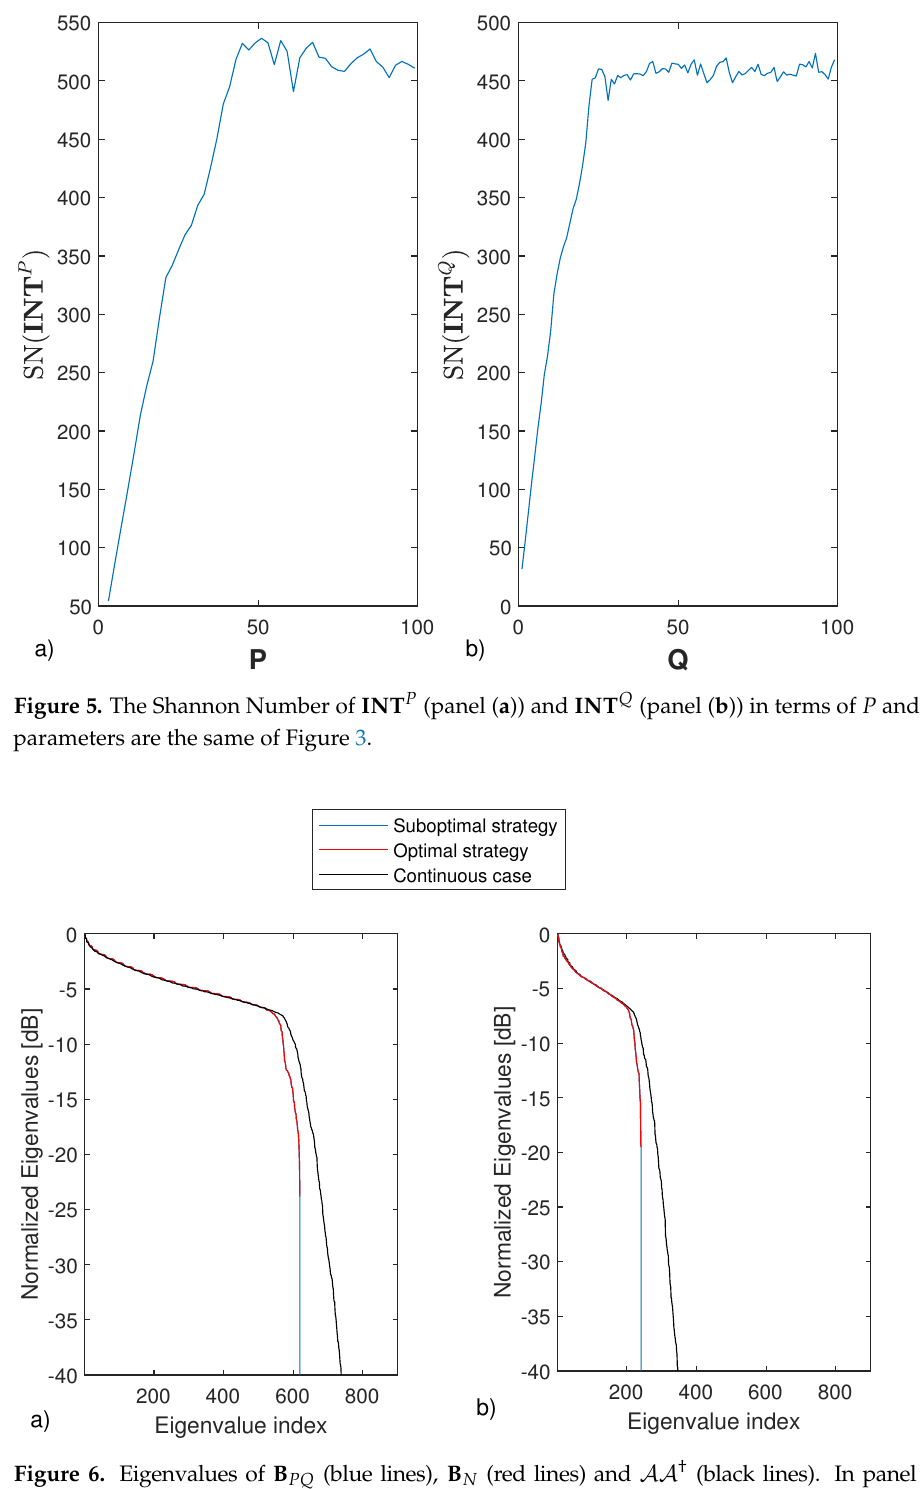
Figure 6. Eigenvalues of B PQ (blue lines), B N (red lines) and AA † (black lines). In panel ( a ), the parameters are the same of Figure 3. In panel ( b ), ID = [ − 3 λ max ,3 λ max ] × [ − 6 λ max ,6 λ max ] , Ω o = 3 [ − π ] rad and Ω = [ k k 0 ] , , π 0 , k 2 2 2